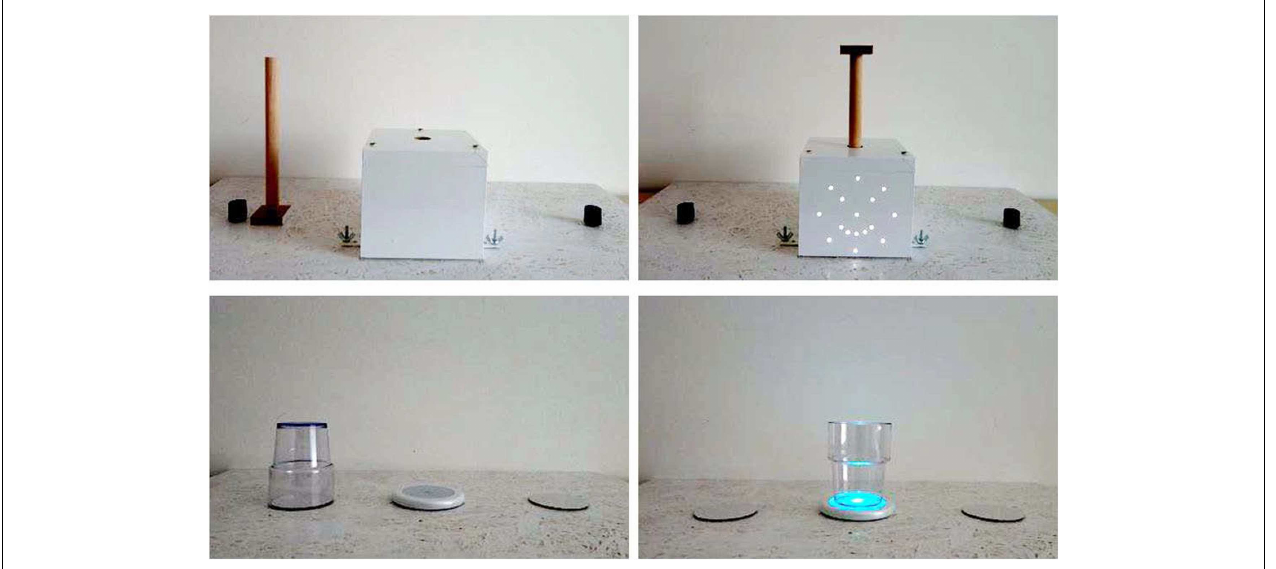
FIGURE 1 | Left column: starting position of the bar and the glass in the critical trial in the bar-transport task and right-hand-trial in the overturned-glass task. Right column: final position of the bar and the glass for the AE groups in the bar-transport task and the overturned-glass task.